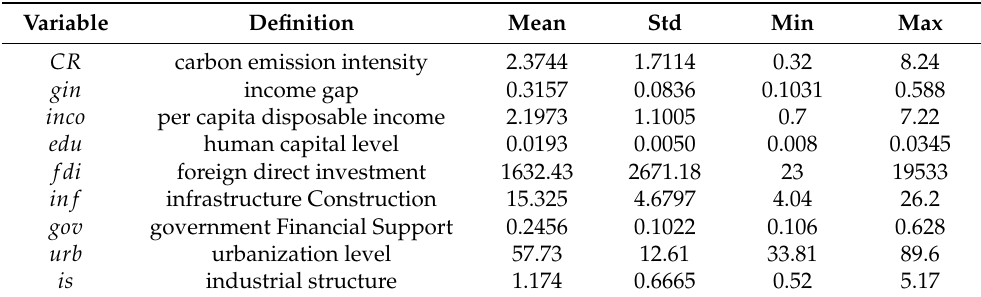
Table 3. Descriptive statistical